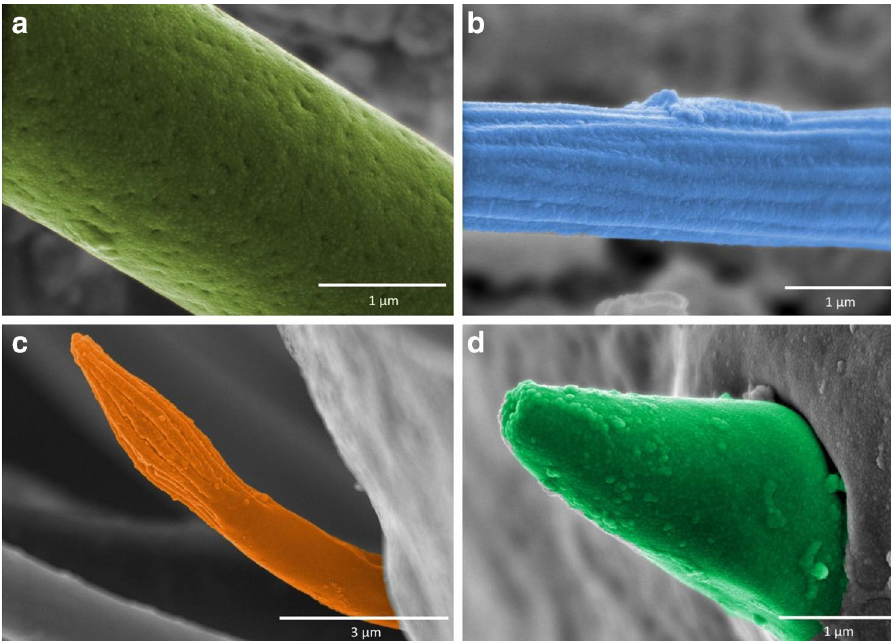
Figure 8. Antennal sensilla; ( a ) the surface of sensilla basiconica SB3 in Cataractocoris marginiventris , ( b ) the surface of sensilla trichodea ST2 in Cataractocoris marginiventris , ( c ) sensilla basiconica SB4 in Laccocoris sp., ( d ) sensilla coeloconica SCo in Laccocoris sp.